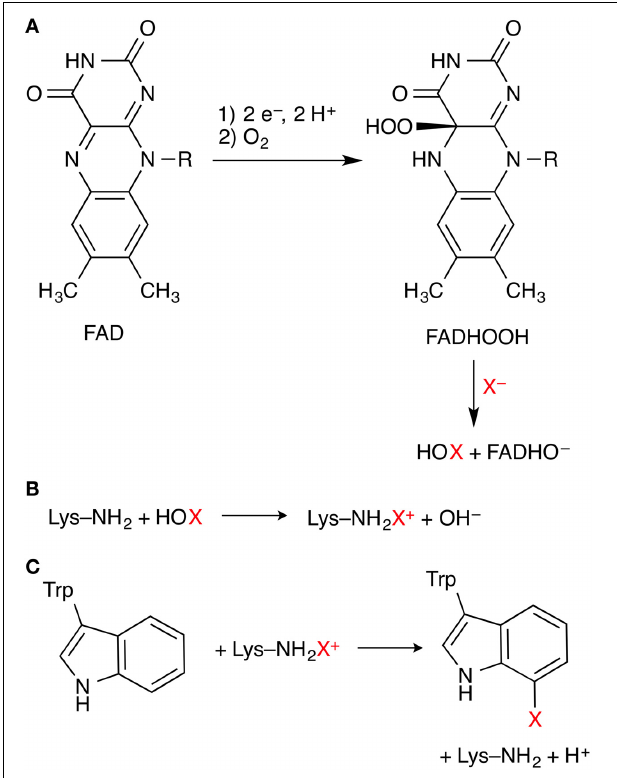
FIGURE 3 | Key steps of the mechanism of flavin-dependent tryptophan 7-halogenases. (A) Formation of FADHOOH, which oxidizes X − to HOX. (B) Proposed formation of a lysine N -haloamine intermediate. (C) Electrophilic aromatic substitution of the substrate